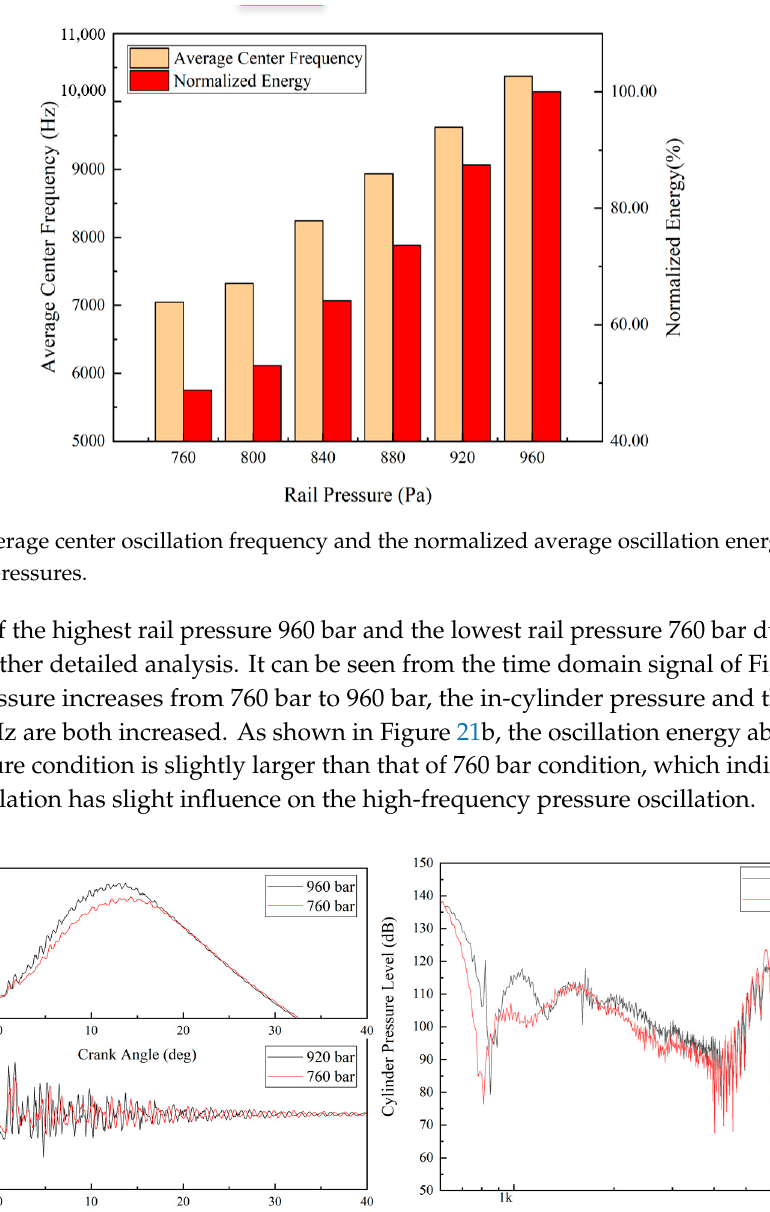
( b ) Figure 22. Time-frequency distributions (TFD) of different rail pressure values: ( a ) 960; ( b ) 760 bar. Detailed center frequency and normalized energy characteristics of in-cylinder pressure oscillation of the two rail pressure conditions are shown in Table 7. It can be clearly seen that as the rail pressure increases, the center frequencies of in-cylinder pressure oscillations of the two conditions are very similar, while more energy will move to high frequencies above 10 kHz, and the corresponding average center frequency will also increase significantly. Table 7. Average Center Frequency and Normalized Energy of 960 and 760 bar. Rail Pressure (bar)